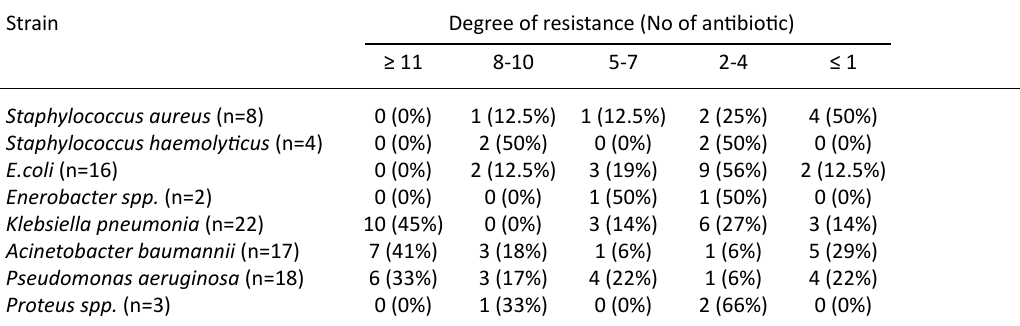
Table 3. Multi-drug resistance pattern of isolated nosocomial bacterial strains Strain Degree of resistance (No of antibiotic)